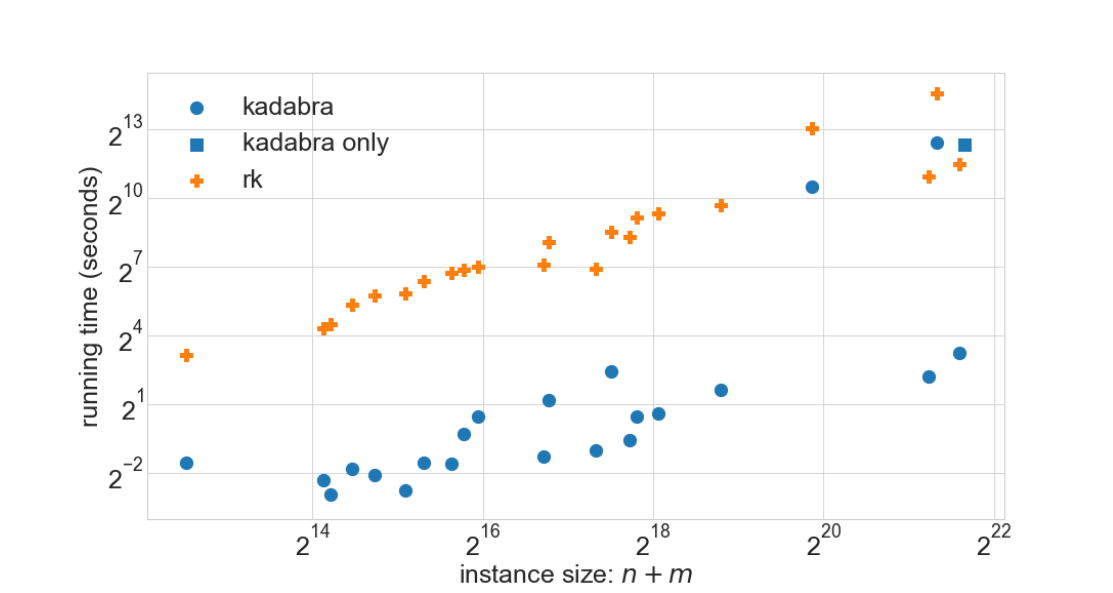
Figure 5. Scatter plot for running times of KADABRA for 4375.0 and RK for all instances in the evaluation set. Both axes are in log scale. Every point is the (arithmetic) mean running time for 5 repeated runs for each instance. The squares represent the run of KADABRA for the networks roadNet-PA (rdPA), roadNet-TX (rdTX) for which RK did not finish within the cutoff time of 7